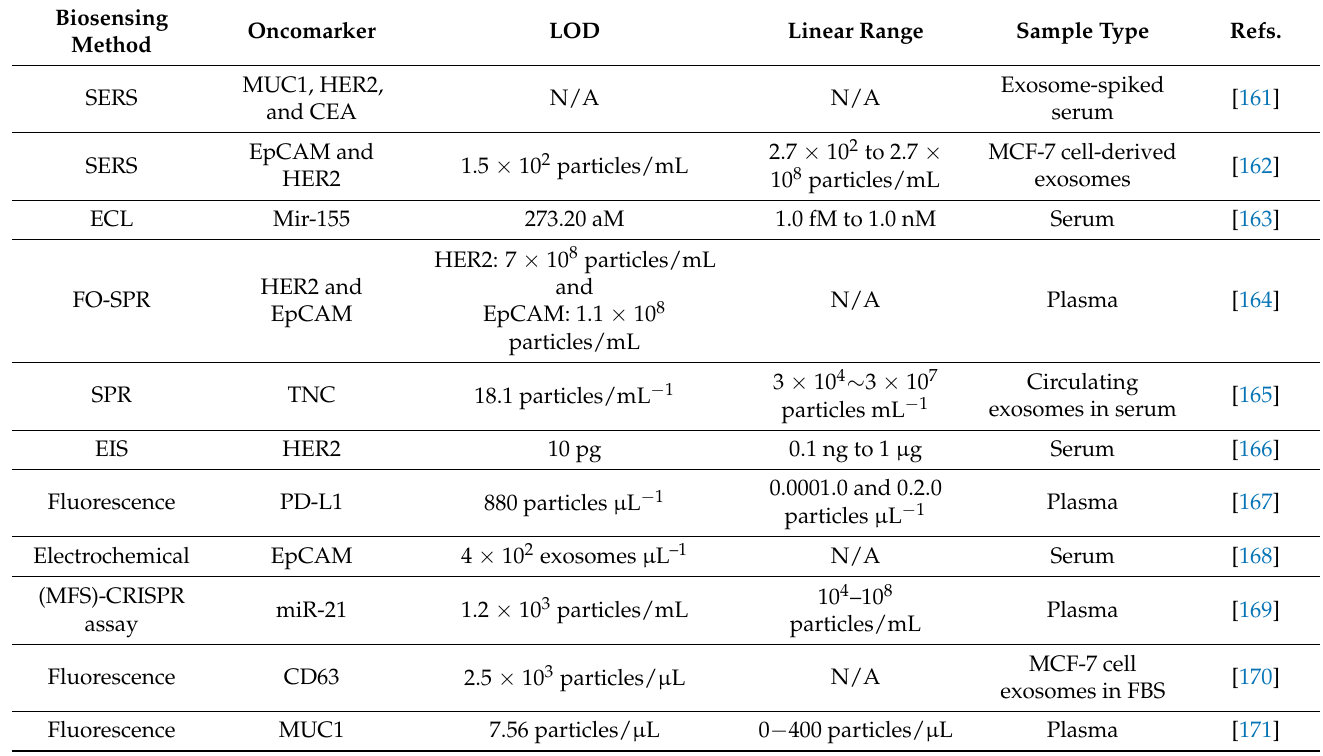
Table 1. Different biosensors for exosomal BC